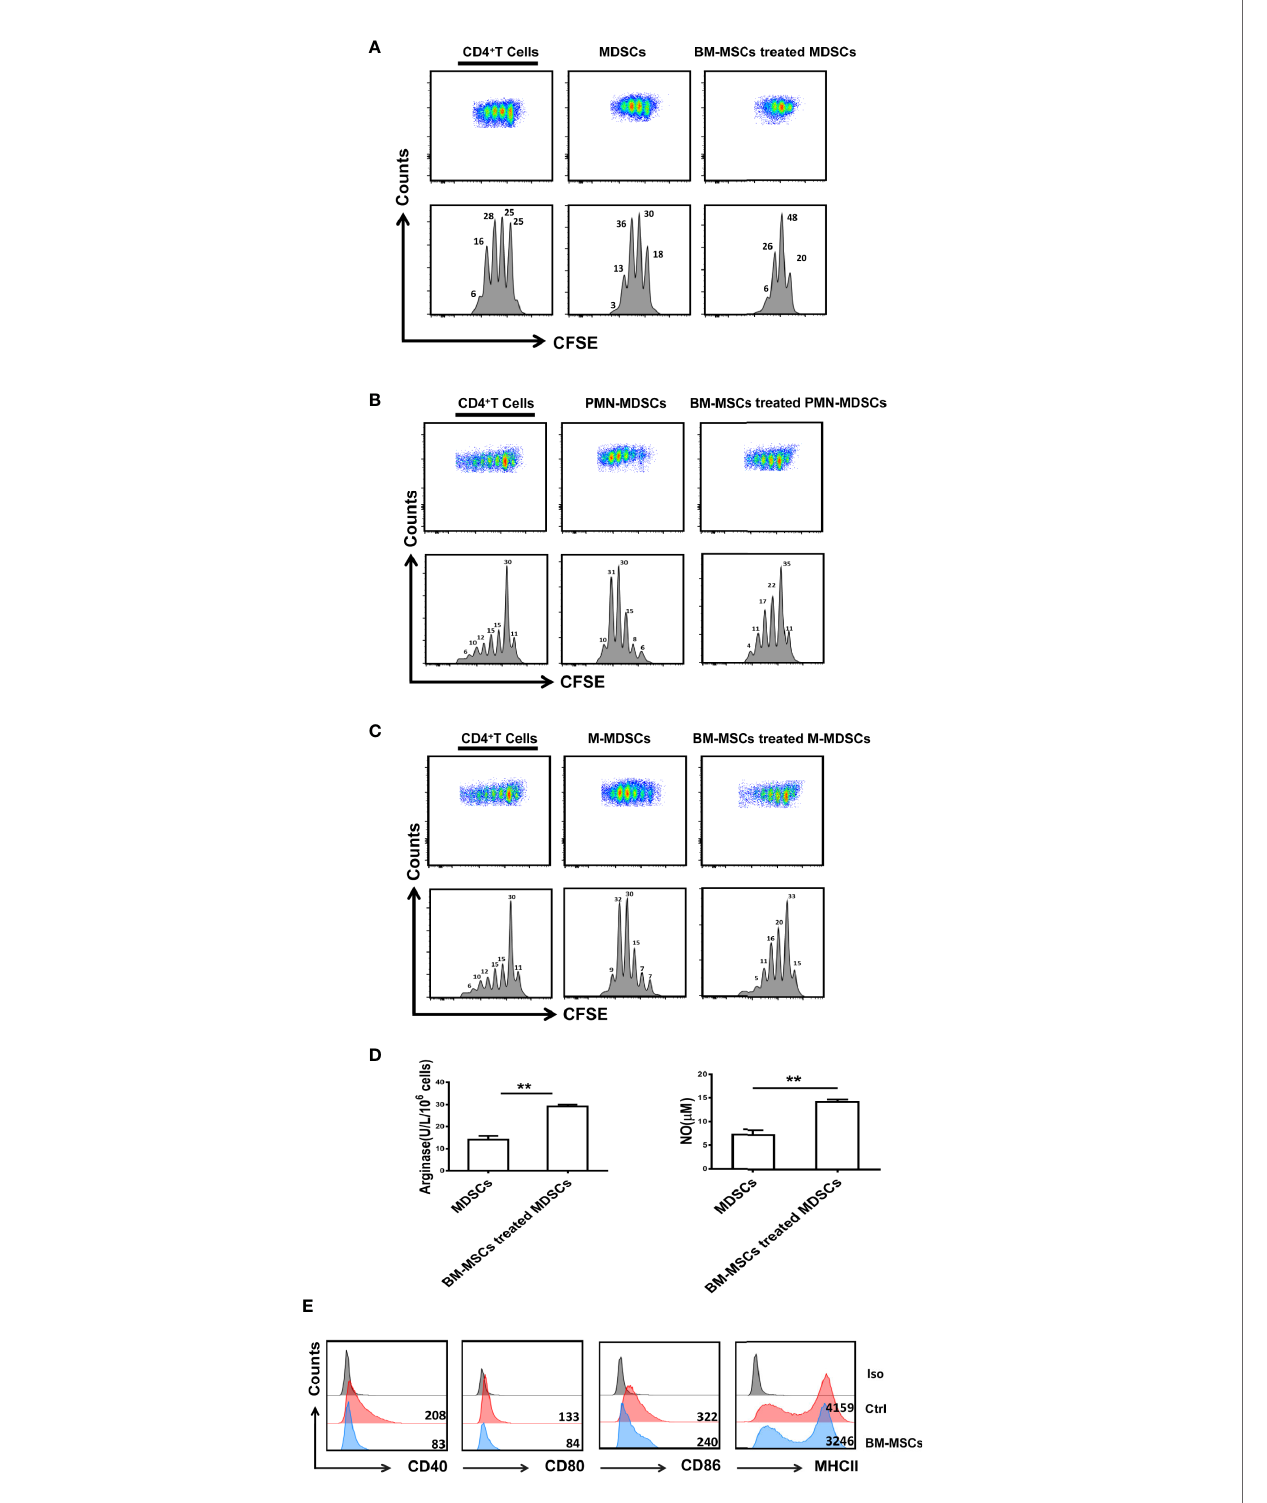
FIGURE 3 | BM-MSCs up-regulate the immunosuppressive function of MDSCs in vitro . (A – C) Total MDSCs (A) , PMN-MDSCs (B), and M-MDSCs (C) isolated from the spleens of ESS mice were treated with BM-MSCs for 48 h, and then MDSCs were collected for co-culture with CD4 + T cells in the presence of anti-CD3 and anti-CD28 mAbs for 72 h (MDSC:T cell ratio 1:1). CD4 + T cell proliferation was evaluated by staining with CFSE. (D) BM-MSCs treated MDSCs were used to measure the activity of arginase activity and the level of NO. (E) The expression of CD40, CD80, CD86, and MHCII on MDSCs in two groups was analyzed by fl ow cytometry. Data are shown as mean ± SD from three independent experiments. **p <